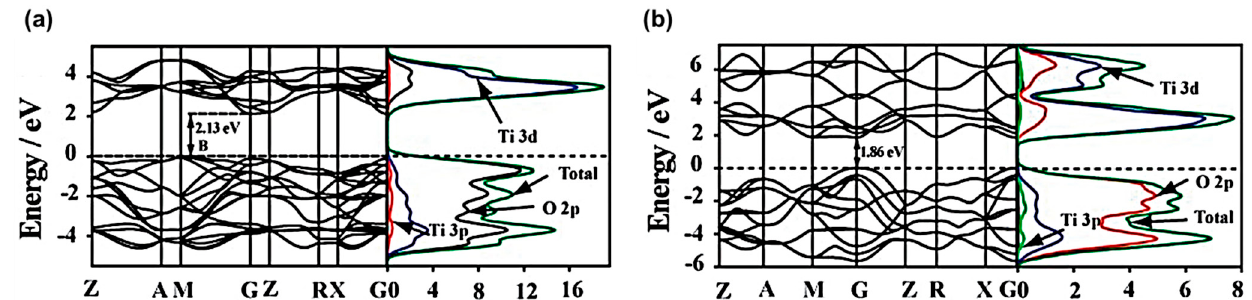
Figure 6. Energy band structure (left panel) and DOS (right panel) for ( a ) anatase and ( b ) rutile TiO 2 [27]; reproduced from [27] with permission from the PCCP Owner Societies.